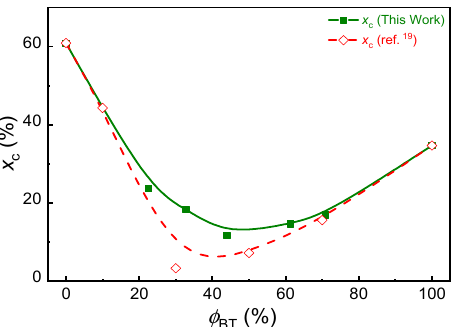
Table 3. Measured gas permeation coefficients ( P WV , P O2 , P CO2 ), diffusion coefficients ( D O2 , D CO2 ) and solubility ( S O2 , S CO2 ) of PBST and PBAT48 copolyesters. Sample